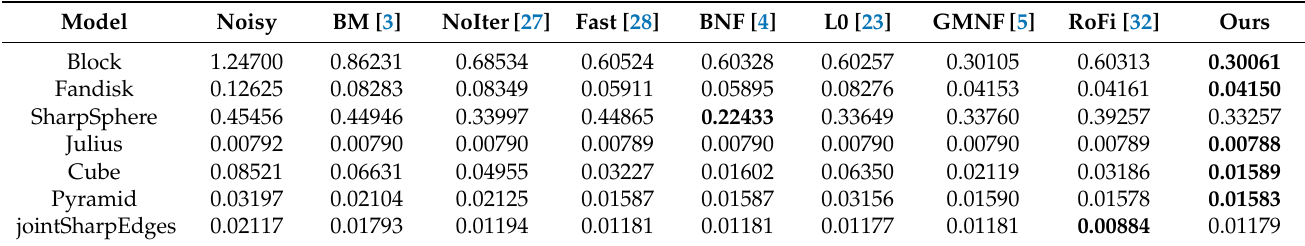
Table 3. The maximum distance D max from the resulting mesh vertices to the ground-truth mesh surface. The lowest value per row is highlighted in